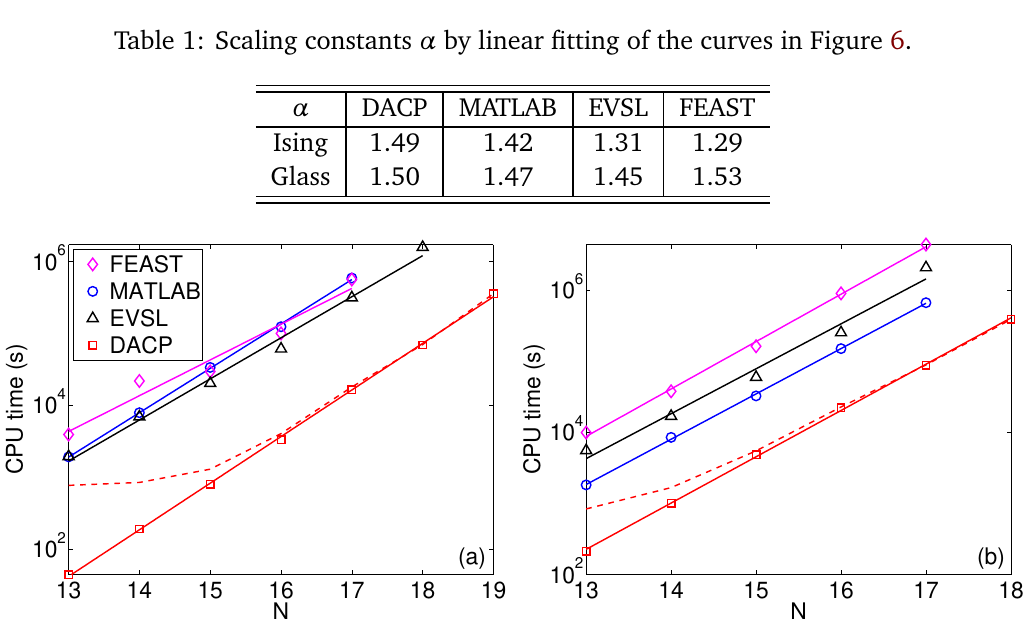
Figure 6: Scaling behavior measured by the computation time (CPU seconds) versus the system size N , for (a) Ising model and (b) spin glass shards model. In both panels, we compare the FEAST algorithm (pink diamonds), the shift-invert method (blue circles) and the EVSL (black triangles) with the DACP method (red squares). Each of the numerical tests (plotted as different marks) illustrates the computation time in finding 5,000 central eigenvalues. The solid lines are obtained via linear fittings. For the DACP method, the red dashed lines present the full solving time T while the red solid squares present the evolution time T E